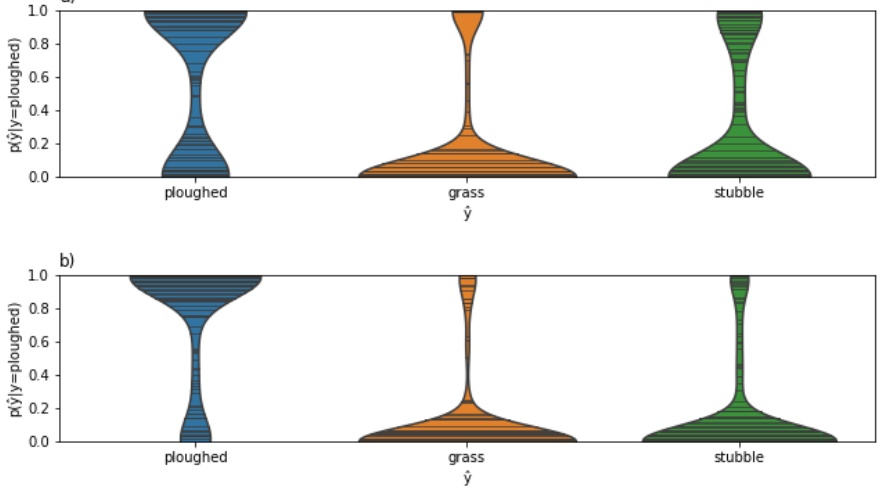
Figure 9. Confidence of small ( a ) vs. large ( b ) ploughed fields being classified as ploughed from a probabilistic perspective, with higher uncertainty for small fields, as